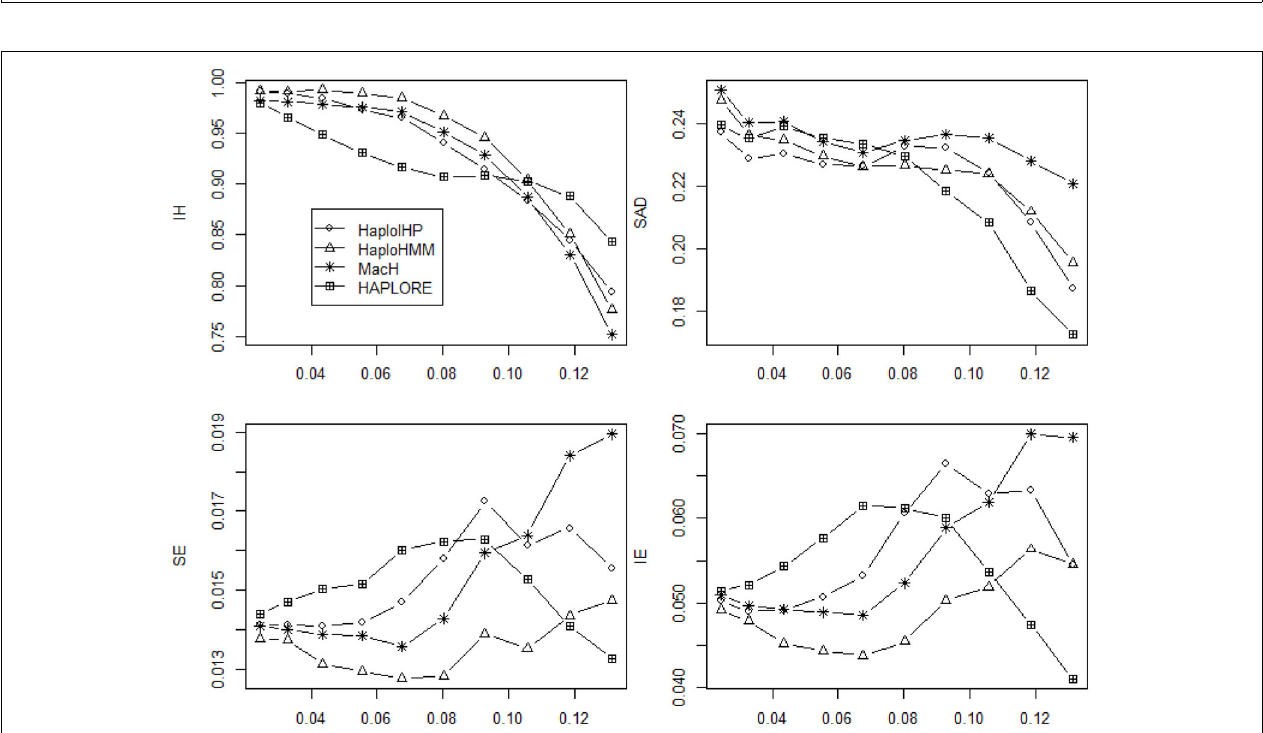
the standard deviation of haplotype frequencies used in simulations. Results were obtained when there was no missing data and there was no incorrect haplotypes included as identified haplotypes.